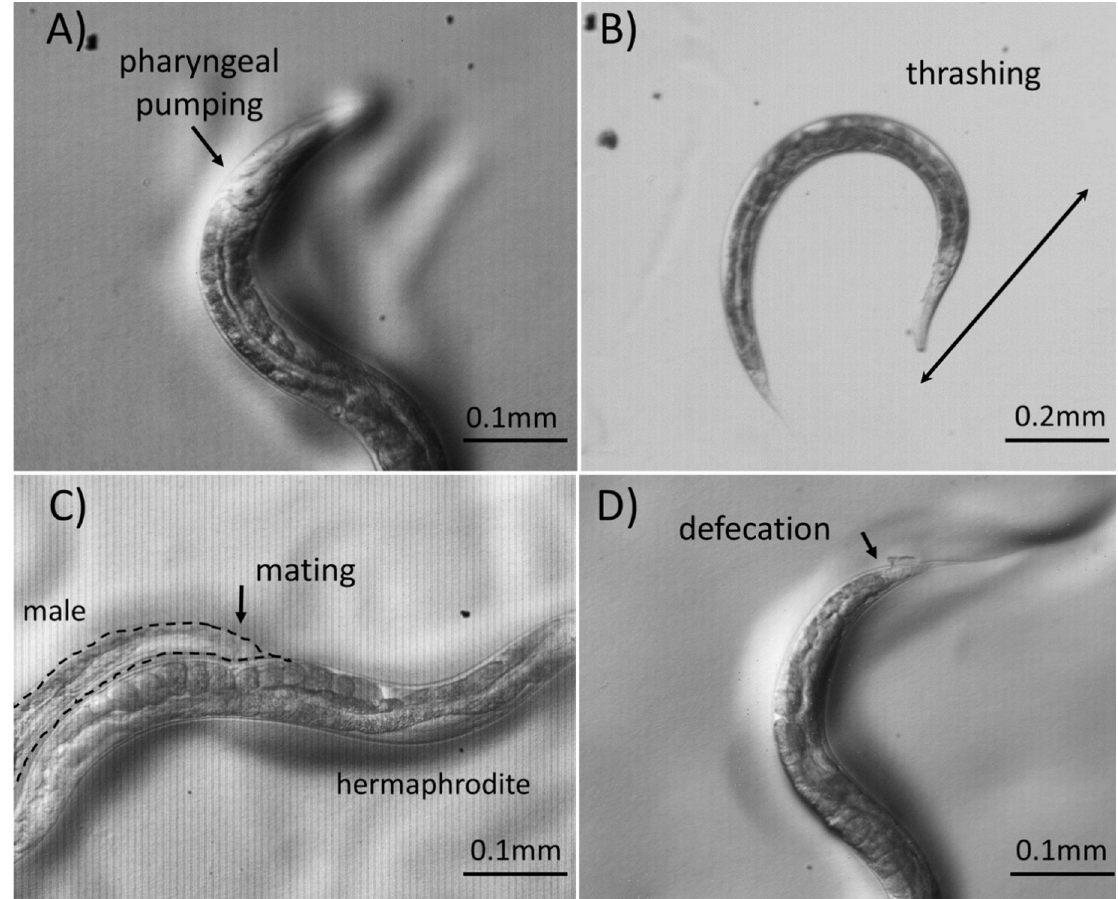
Fig 7. Aging-associated phenotypes and other nematode specific behavior are made easier to analyze by capturing videos at high speed. Still images of various processes taken from the videos of respective speed are included: (a) pharyngeal pumping at 100 fps; (b) thrashing at 210fps; (c) mating behavior at 210fps and 8x analog gain; and (d) defecation at 210fps.